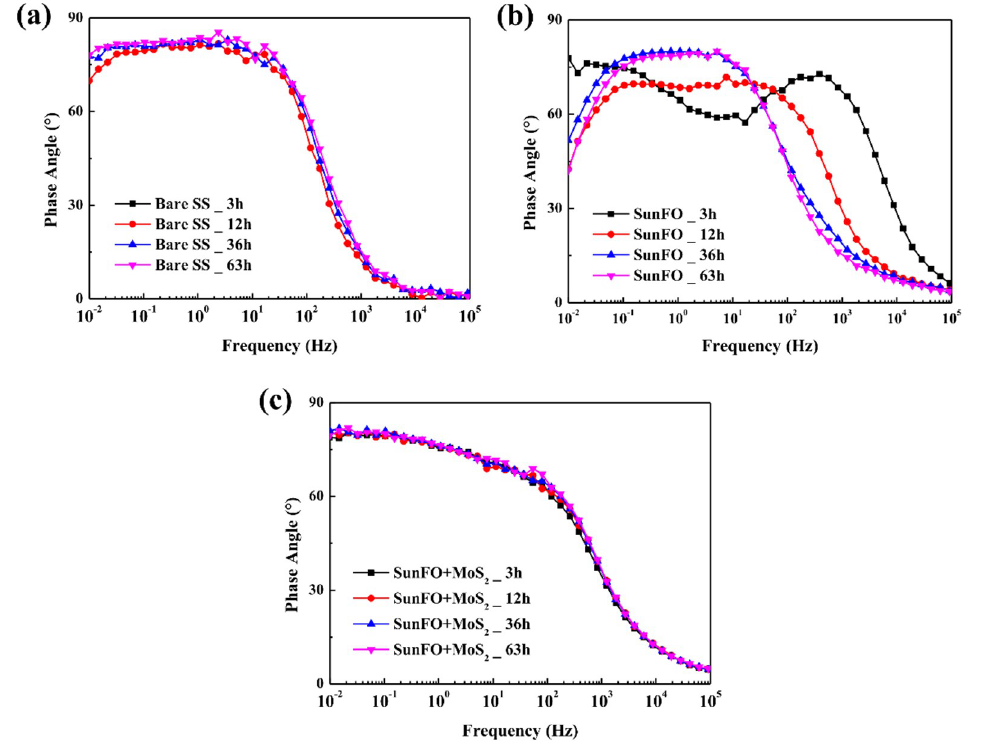
Figure 9. EIS results in the form of Bode plot in 3.5% NaCl solution: ( a ) Bare SS, ( b ) SunFO coated SS, ( c ) SunFO + MoS 2 coated SS.